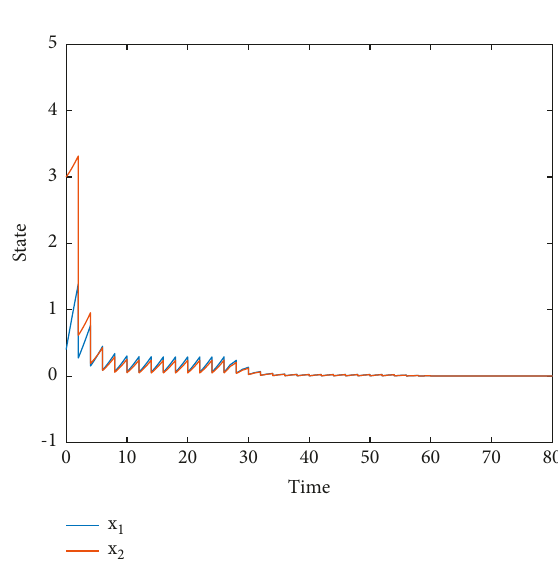
Figure 3: The state of (39) and (40) with τ � 5.